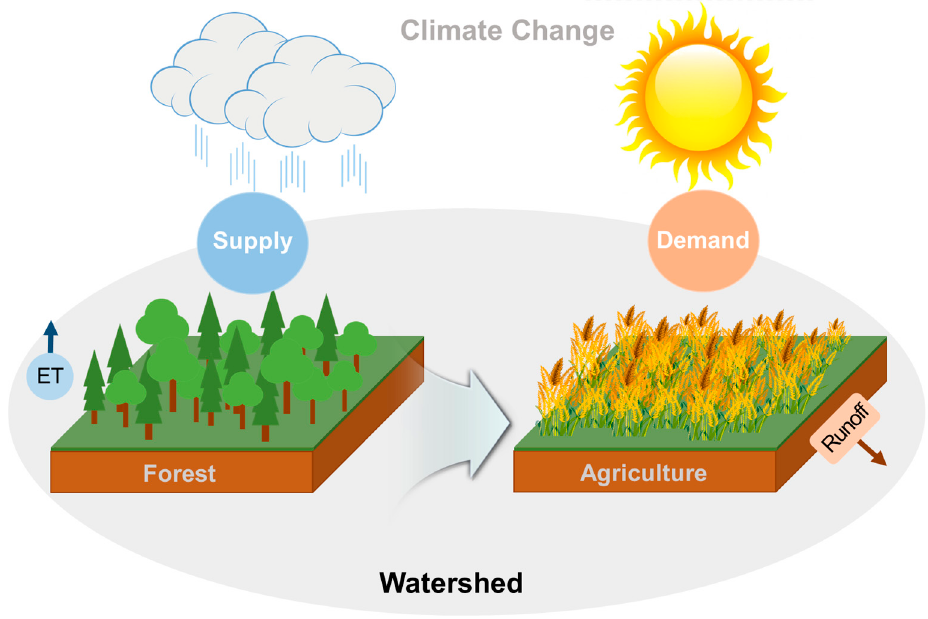
Figure 2. Conceptual diagram of the water-centric nexus for agriculture and forest attributable to climate change.